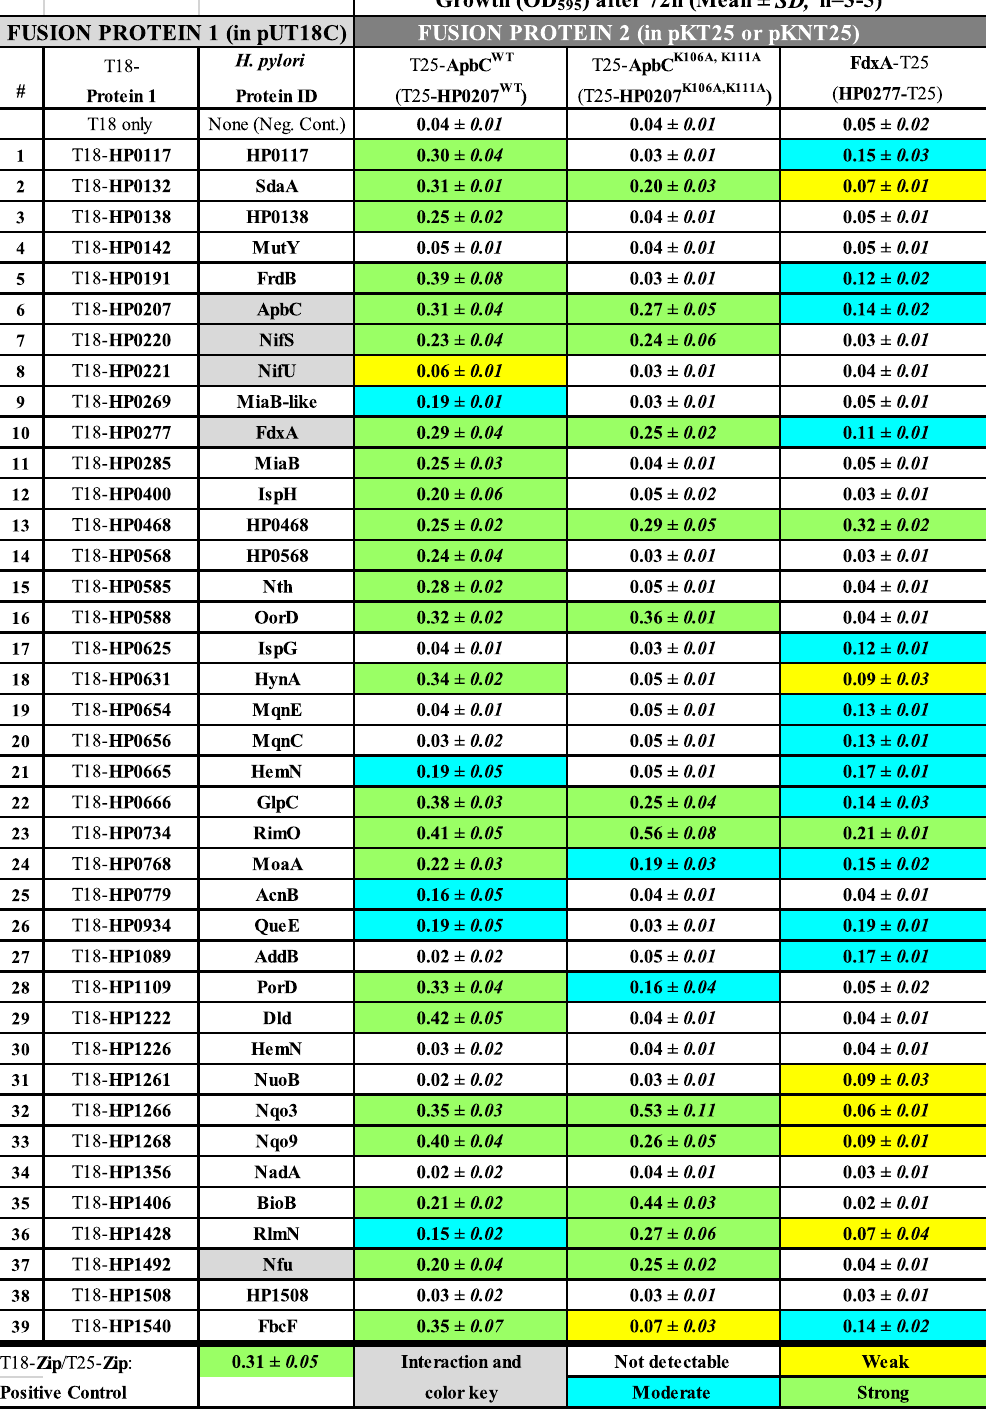
Table 2. Growth of co-transformed E. coli BTH101 cells in M63-maltose minimal